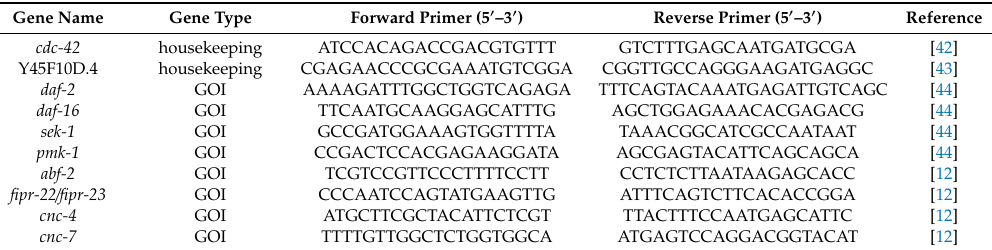
Table 3. Targeted C. elegans genes primers for qPCR